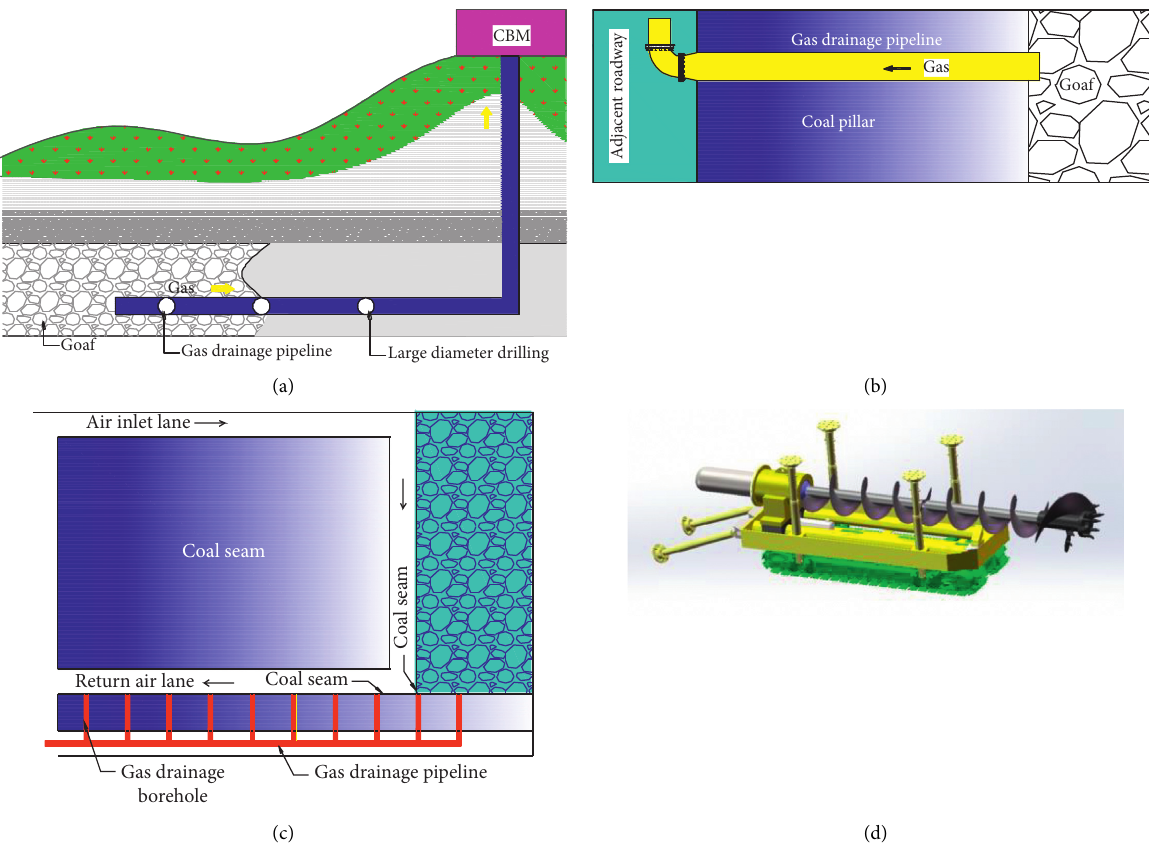
Figure 1: Schematic diagram of the large-diameter drilling extraction. (a) Gas drainage diagram. (b) Section diagram of extraction borehole. (c) Plane diagram of extraction drilling. (d) Schematic diagram of drilling